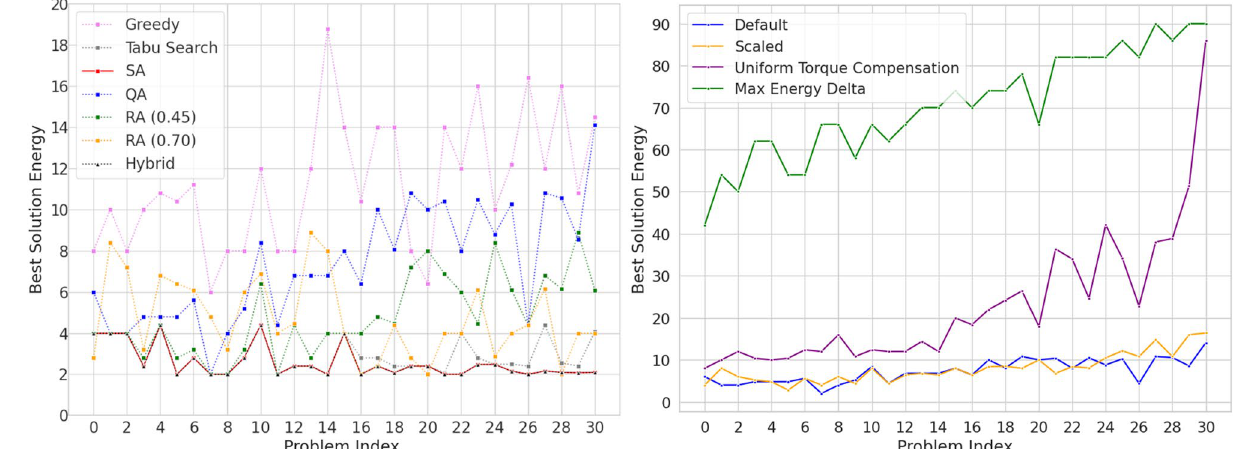
Figure 6. Energy plot of the best solution obtained with different methods: Simulated Annealing (SA), 3 Quantum Annealing (QA) with a time durations of 20 µ s and 10 samples, Reverse Annealing at different tunneling field level (RA), classical (greedy and Tabu Search) and hybrid solvers. The instances on the x-axis are indexed by increasing number of variables. ( Left ) Solutions obtained for different problem instances. Note that Tabu Search, SA and Hybrid often overlap for small problem indexes. ( Right ) Solution obtained with QA by adopting different chain break mitigation strategies.